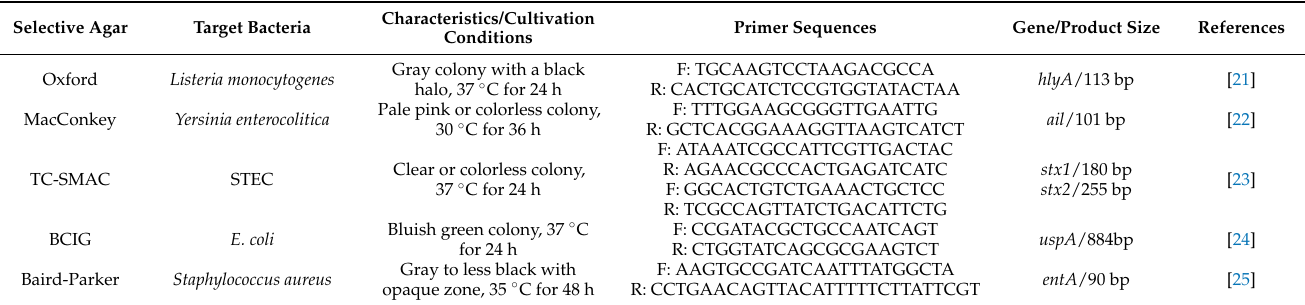
Table 1. Selective agars, cultivation conditions, and primer sequences used in the